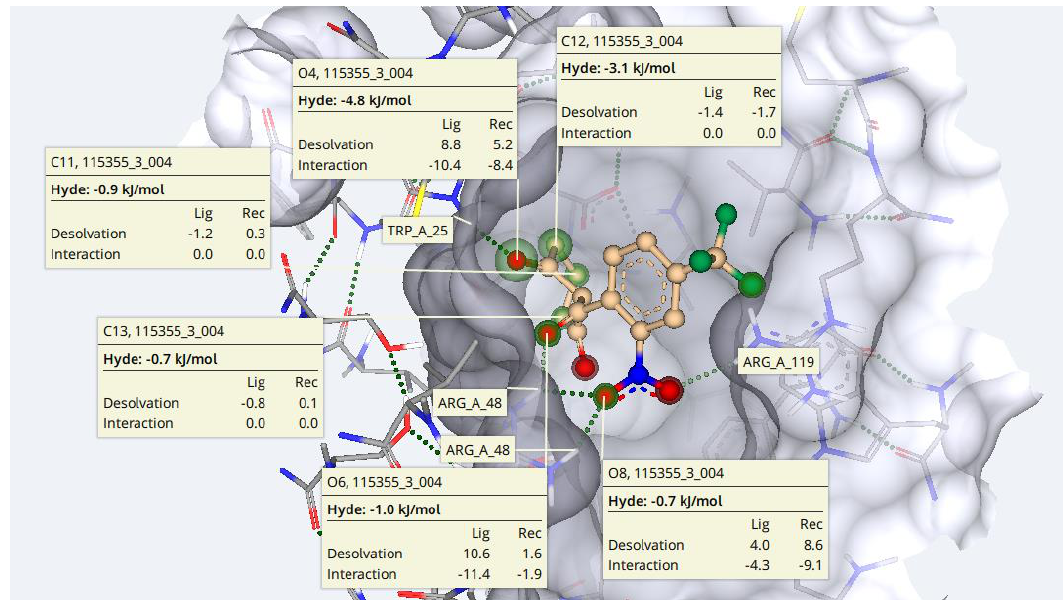
Figure 5. HYDE estimation of nitisinone. According to HYDE calculations, O4, O6, O8, C11, C12, and C13 have a major contribution to the overall estimated affinity of the docked complex.